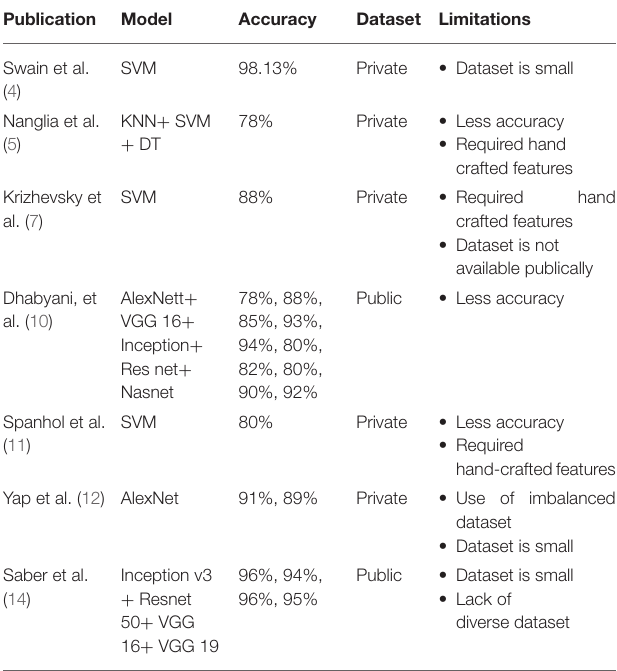
TABLE 1 | Comparison and limitations of previous